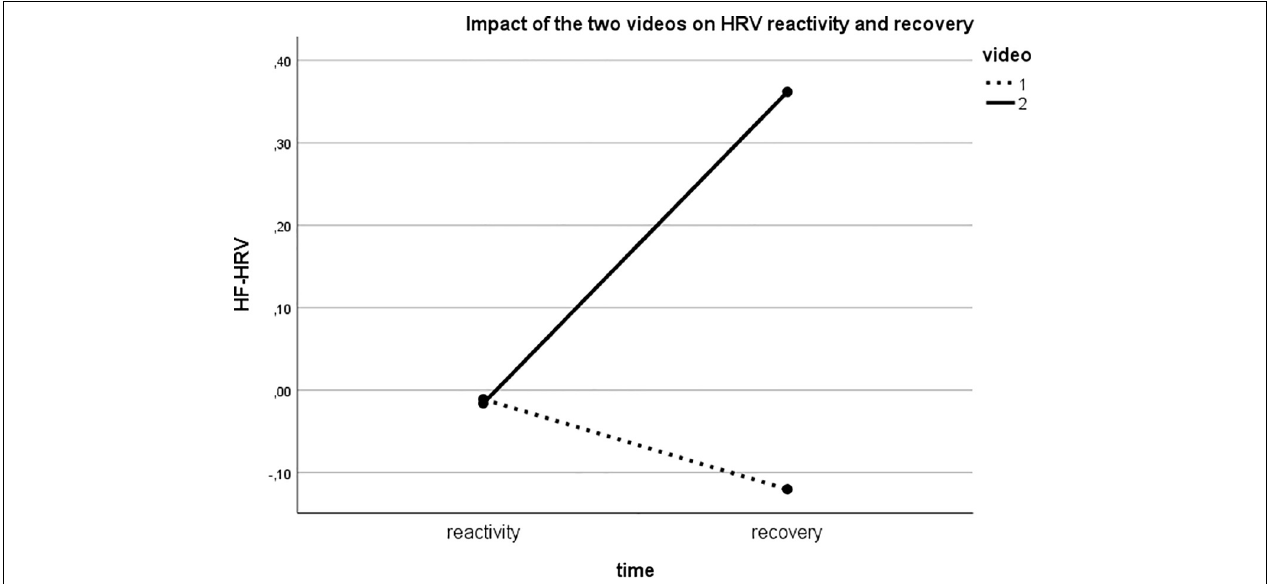
FIGURE 2 | Significant Time by Video interaction showing that while reactivity to the two videos did not differ, high-frequency heart rate variability (HF-HRV) increased during recovery from Video 2 (action component of compassion) but decreased during recovery from Video 1 (empathic sensitivity component of